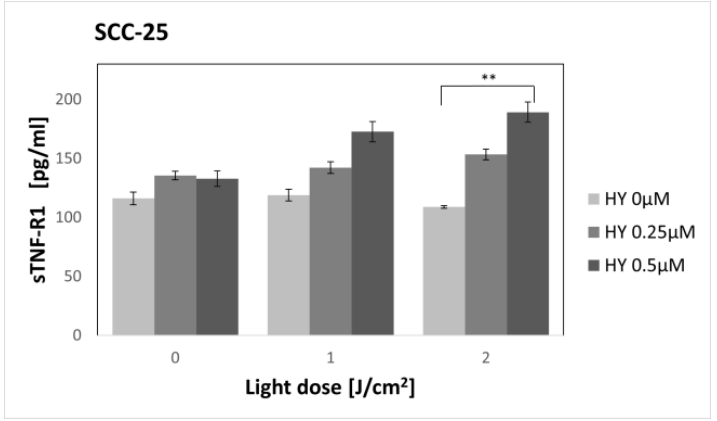
Figure 9. The concentration of sTNF-R1 in the supernatants from oral cancer cell culture SCC-25 line. The values represent the means ± SE. ** p < 0.05.